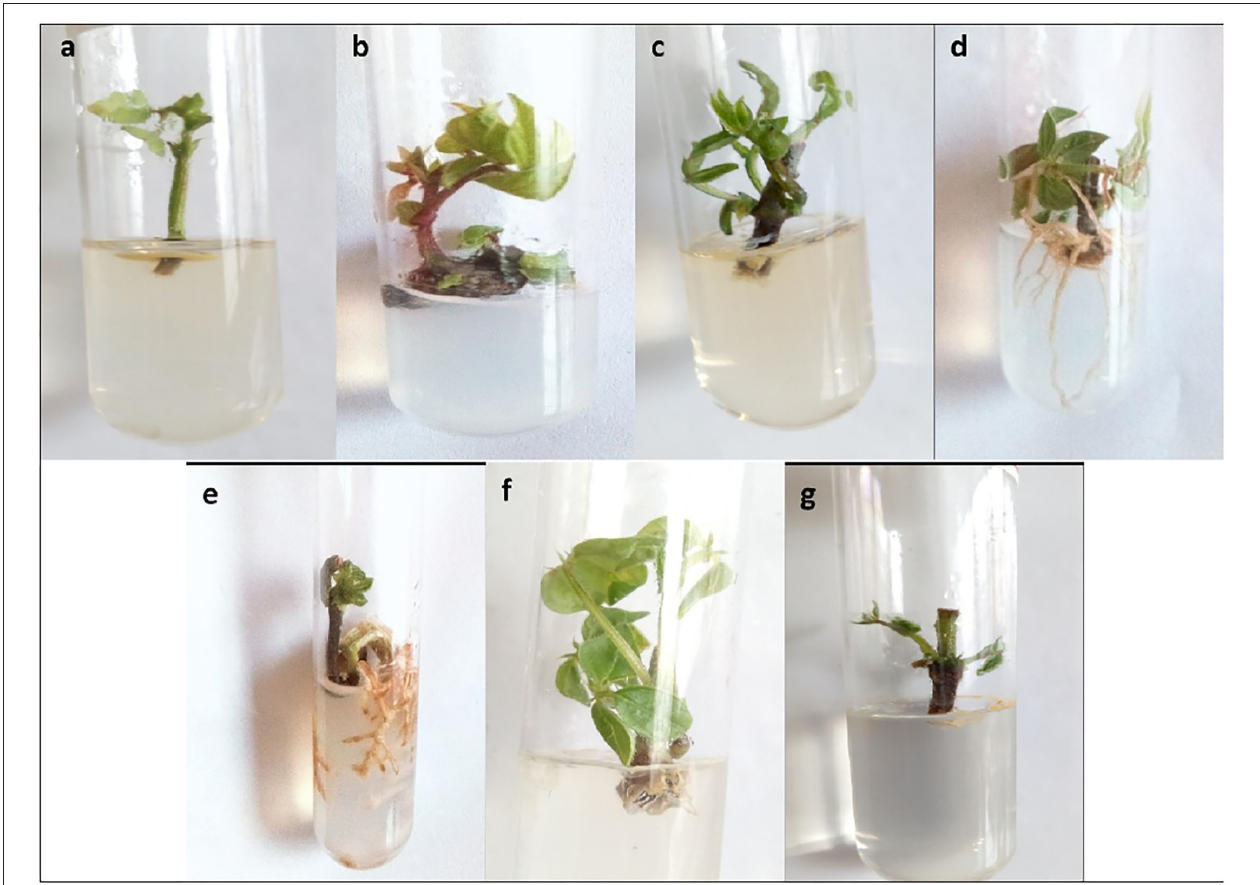
FIGURE 3 | In vitro culture establishment of three varieties of mung bean (a) Variety 1 (shoot tip) in MS + BAP 1 mg/L; (b) Variety 2 (shoot tip) in MS + BAP 1 mg/L; (c) Variety 3 (shoot tip) in MS + BAP 1 mg/L; (d) Variety 1 (Shoot tip) in MS + IBA 1 mg/L; (e) Variety 2 (Shoot tip) in MS + IBA 1 mg/L; (f) Variety 3 (Shoot tip) in MS + IBA 1 mg/L; (g) Variety 1 (node) in MS + BAP 1